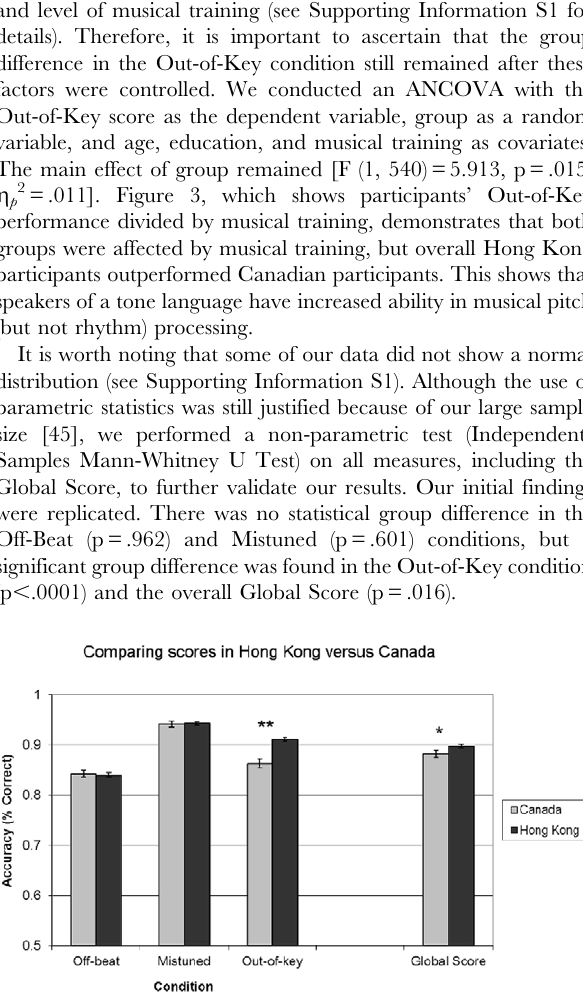
Figure 3. Hong Kong and Canadian younger participants’ Out- of-Key performance divided by group. Musical training is classified into 5 levels: 1=less than one year, 2=1–3 years, 3=4–6 years, 4=7–10 years, and 5=more than 10 years.